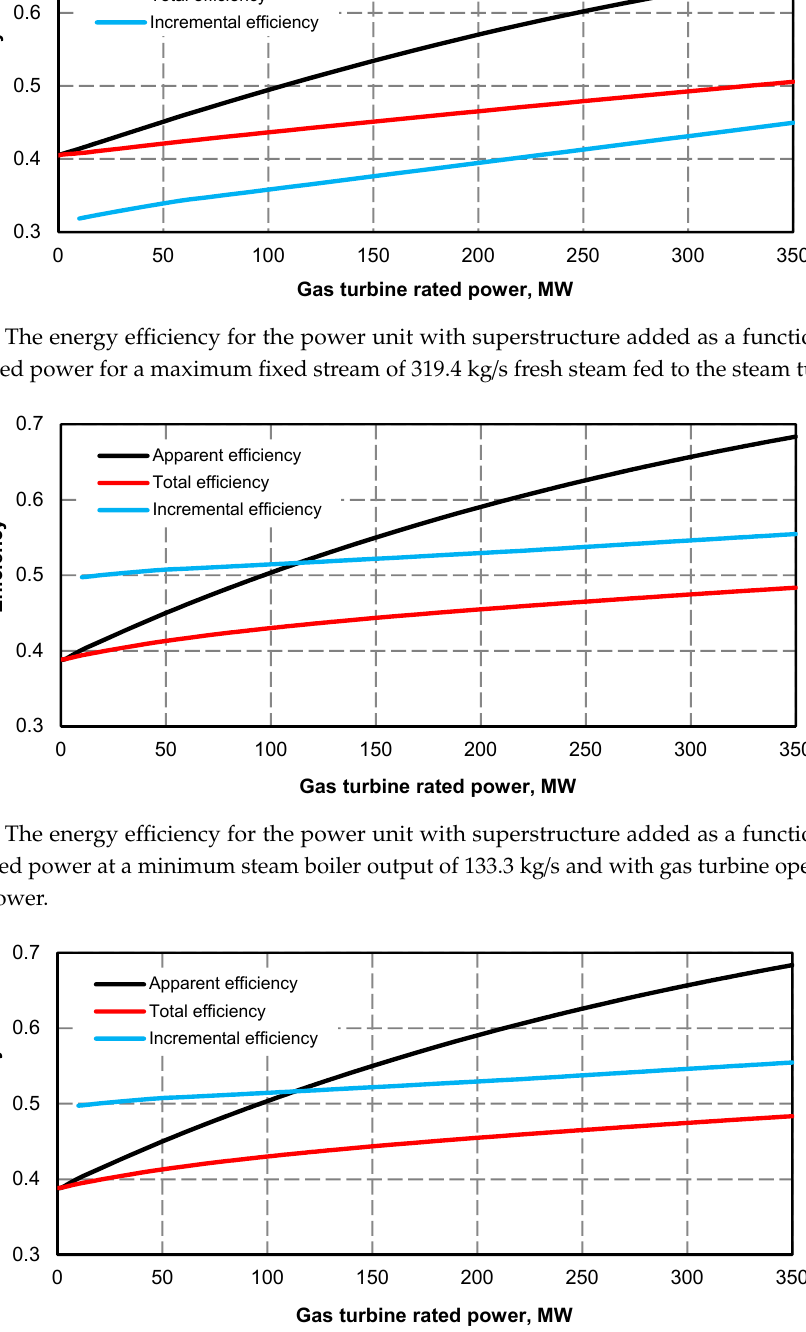
Figure 35. The energy e ffi ciency for the power unit with superstructure added as a function of gas turbine rated power at a minimum steam boiler output of 133.3 kg / s and gas turbine operating at 60% of its rated power.